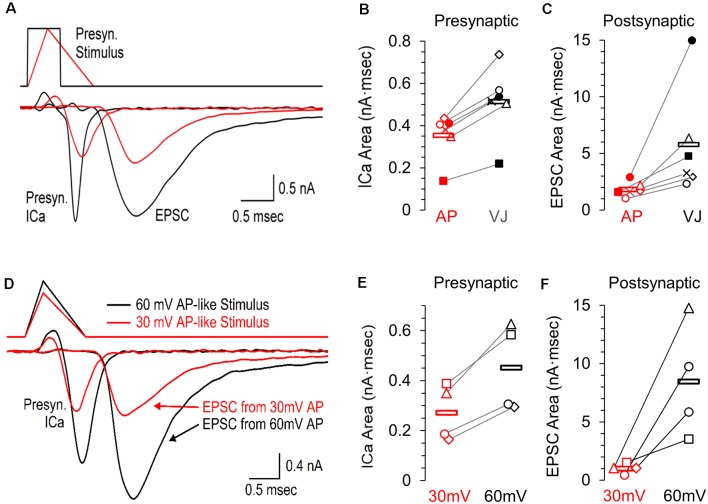
Presynaptic calcium channel activity and simultaneously recorded postsynaptic response to an AP-like stimulation, an area matched voltage-jump stimulation, and the effects of AP-like stimulation amplitude. (A) Simultaneous pre- and postsynaptic recordings using a presynaptic voltage-jump stimulus (black traces) or an AP-like stimulus (red traces) consisting of a 0.3 ms ramped depolarization and 0.7 ms ramped repolarization; both with a peak amplitude of +30 mV. These representative recordings from a single cell show the presynaptic calcium current, followed by the corresponding excitatory postsynaptic current (EPSC). (B) Individual values and average area of the presynaptic calcium current (n = 6 paired recordings) in response to the voltage jump (avg. 0.512 ± 0.068, black) or the AP-like stimulation (avg. 0.352 ± 0.044 SE, n = 6 paired recordings, red). (C) Individual values and average area of the EPSC (n = 6 paired recordings) in response to a presynaptic voltage jump stimulus (avg. 5.74 ± 1.93, black) or an AP-like stimulation (avg. 1.81 ± 0.26, red). (D) Simultaneous pre- and postsynaptic recordings using a presynaptic AP-like stimulus consisting of a 0.3 ms ramped depolarization and 0.7 ms ramped repolarization and a peak amplitude of 30 mV (red) or 60 mV (black). (E) Individual values and average area of the presynaptic calcium current (n = 4 paired recordings) in response to an AP-like stimulation with a peak amplitude of 30 mV (avg. 0.27 ± 0.05 SE, red) or 60 mV (0.45 ± 0.09, black). (F) Individual values and average area of the excitatory postsynaptic current (EPSC, n = 4 paired recordings) in response to an AP-like stimulation with a peak amplitude of 30 mV (avg. 1.01 ± 0.22 SE, red) or 60 mV (8.47 ± 246 SE, black).